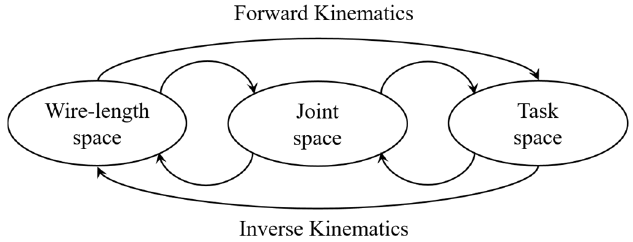
Figure 3. Relation between three spaces of kinematics of wire-driven robotic